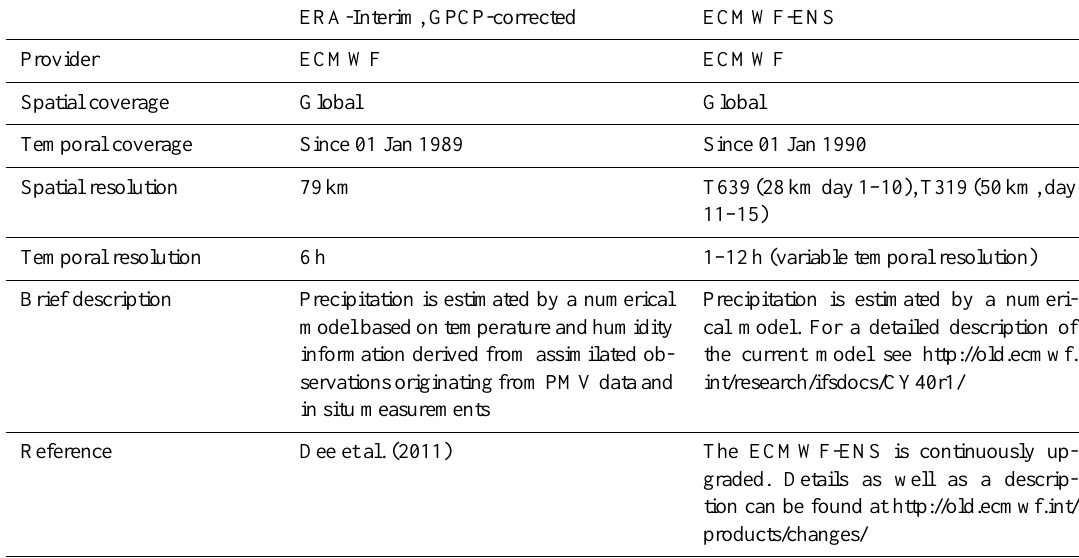
Table 2. Meteorological input